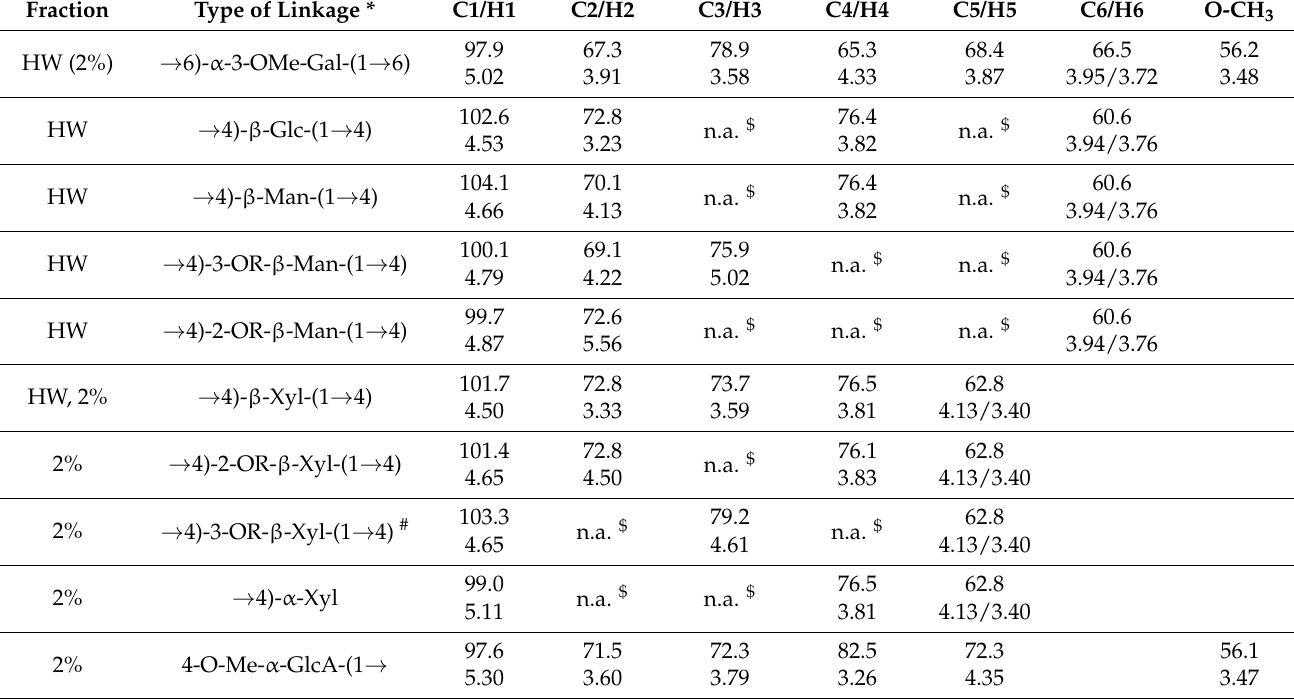
* R indicates acetyl group (OAc 2.19/20.6 ppm) or, in the case of 2-OR- β -Xyl, 2-O-linked 4-O-Me- α -GlcA; # tentative assignment; $ not